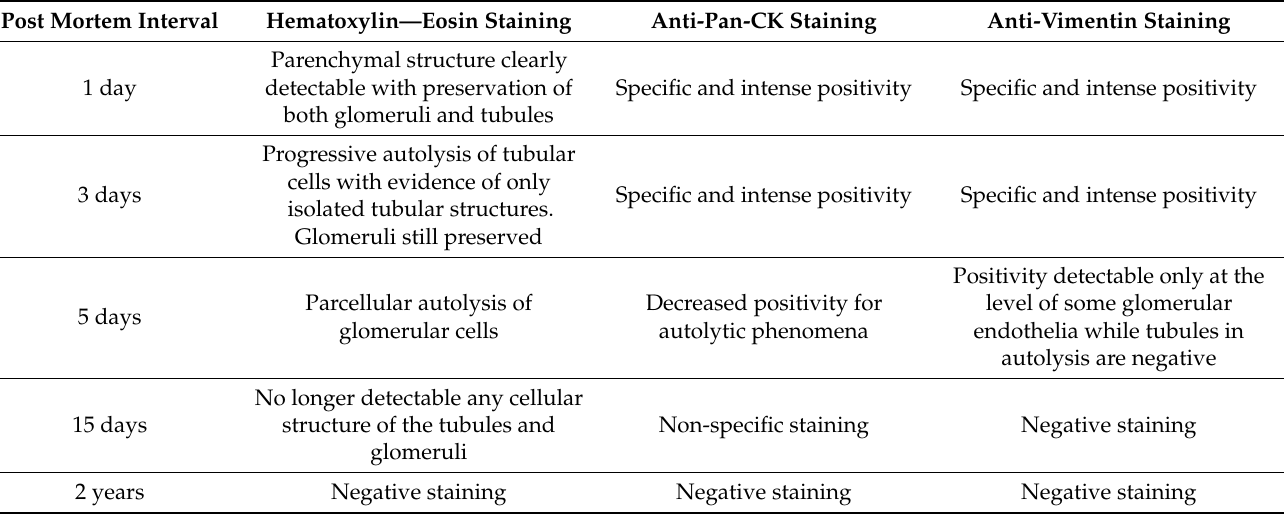
Table 3. Immunohistochemical evaluation of cytokeratin and vimentin in kidney tissues.